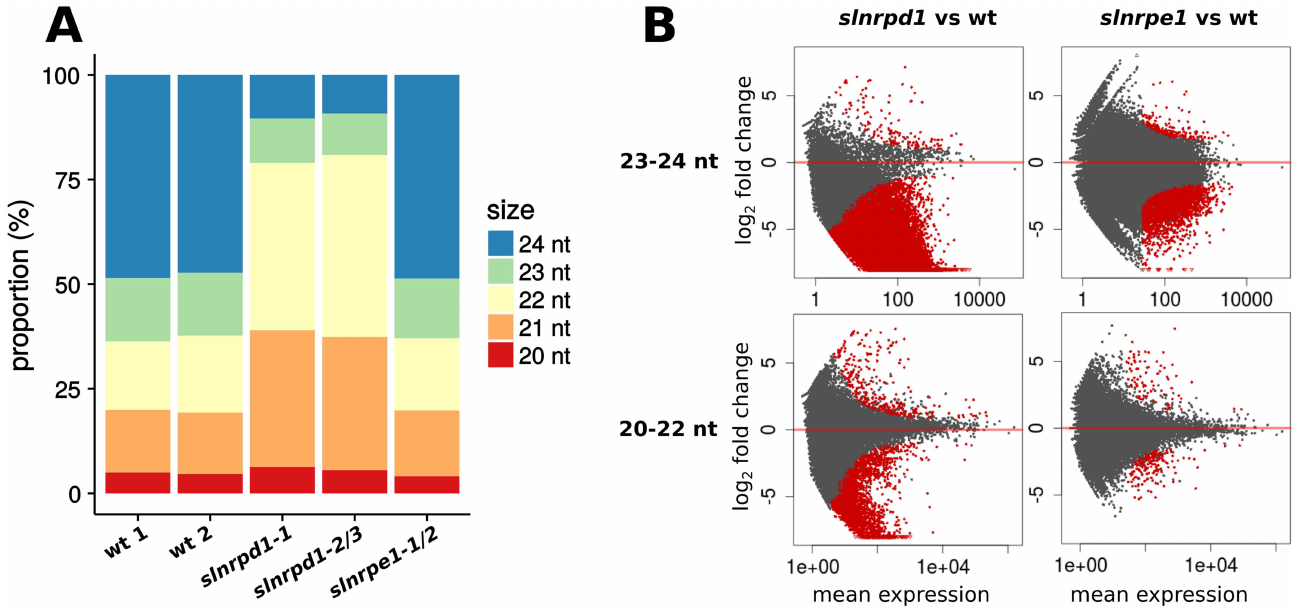
Fig 4. Conserved functions of tomato SlNRPD1 and SlNRPE1 in 24-nt sRNA biogenesis. (A) Size profile of small RNA populationsin wt, slnrpd1 and slnrpe1 (two wt and slnrpd1 replicates, one slnrpe1 sample). (B) MA-plot of 23–24-ntand 20–22-ntsRNA loci in wt versus slnrpd1 and slnrpe1 . Loci whose sRNA accumulationdiffered significantly(adjustedp-value < 0.05) betweenthe wild-typeand mutant line are plotted in red.